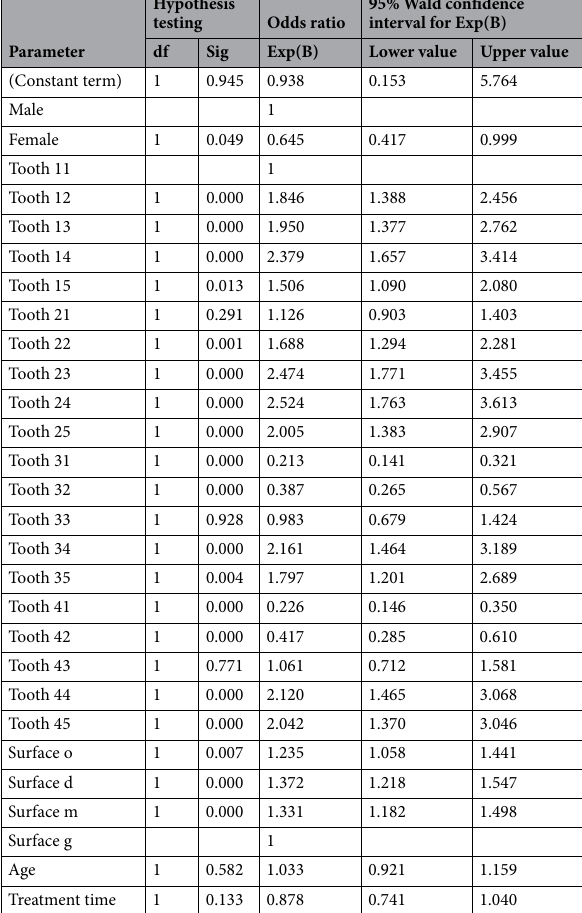
Table 4. Overview of the parameters for logistic regression: WSL after MB